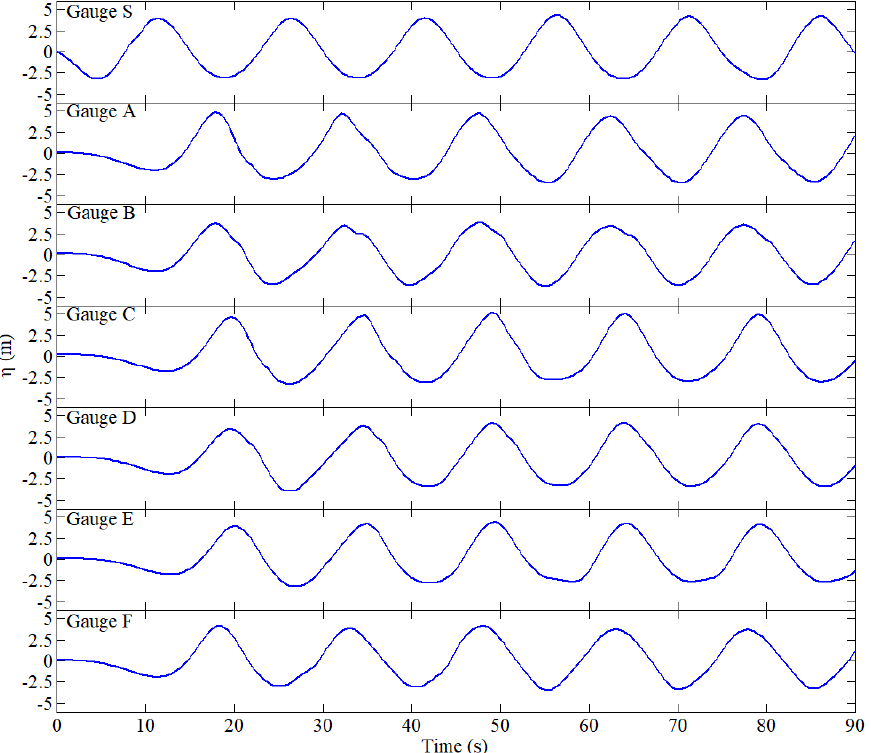
Figure 7. Evolutionary time history of wave profiles at different typical positions around the pile legs of the jack-up platform (note: the typical positions A – F and S have been labeled in Figure 1b).